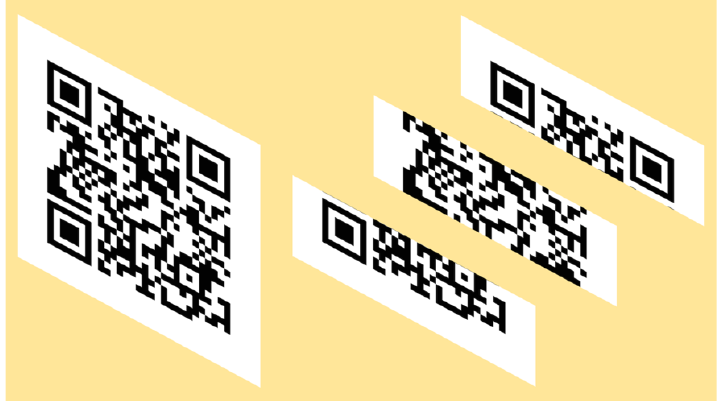
Figure 9. Example of a static QR code split on three different levels. Schematic example of the segmentation strategy proposed by Chen et al. [13] (the static QR code redirects to A. Sola’s ORCID page, https://orcid.org/0000-0002-8649-9388, accessed on 22 December 2021).